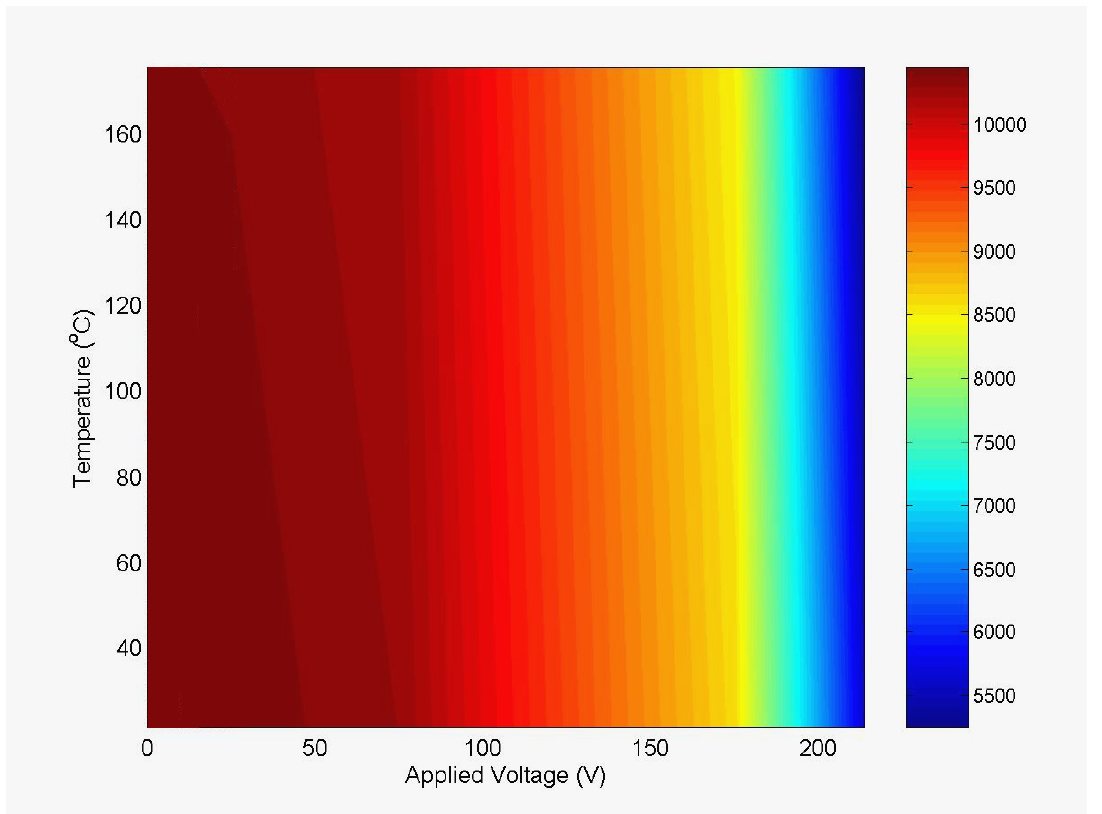
Figure 4. Resonant frequency map obtained for the G1 AFM cantilever as a function of the temperature and applied DC